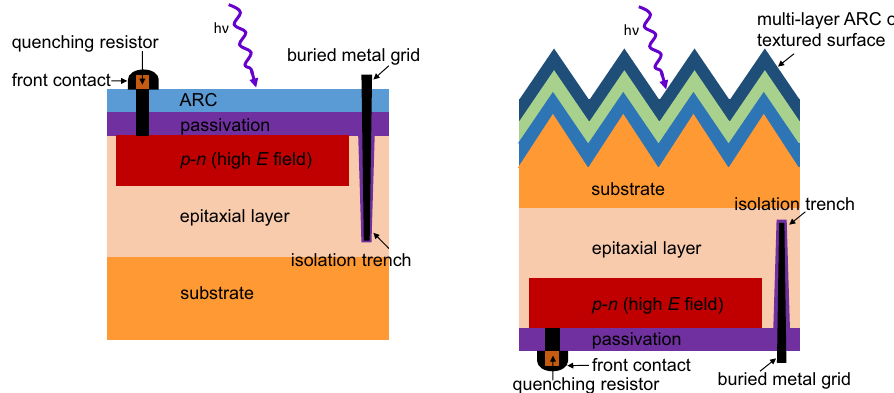
Figure 11. Schematic comparison of the SiPM cross-sections: (left) the conventional front-illuminated SiPM with ARC on planar surface, and (right) the back-illuminated SiPM with multi-layer ARC on textured surface that is developed in this